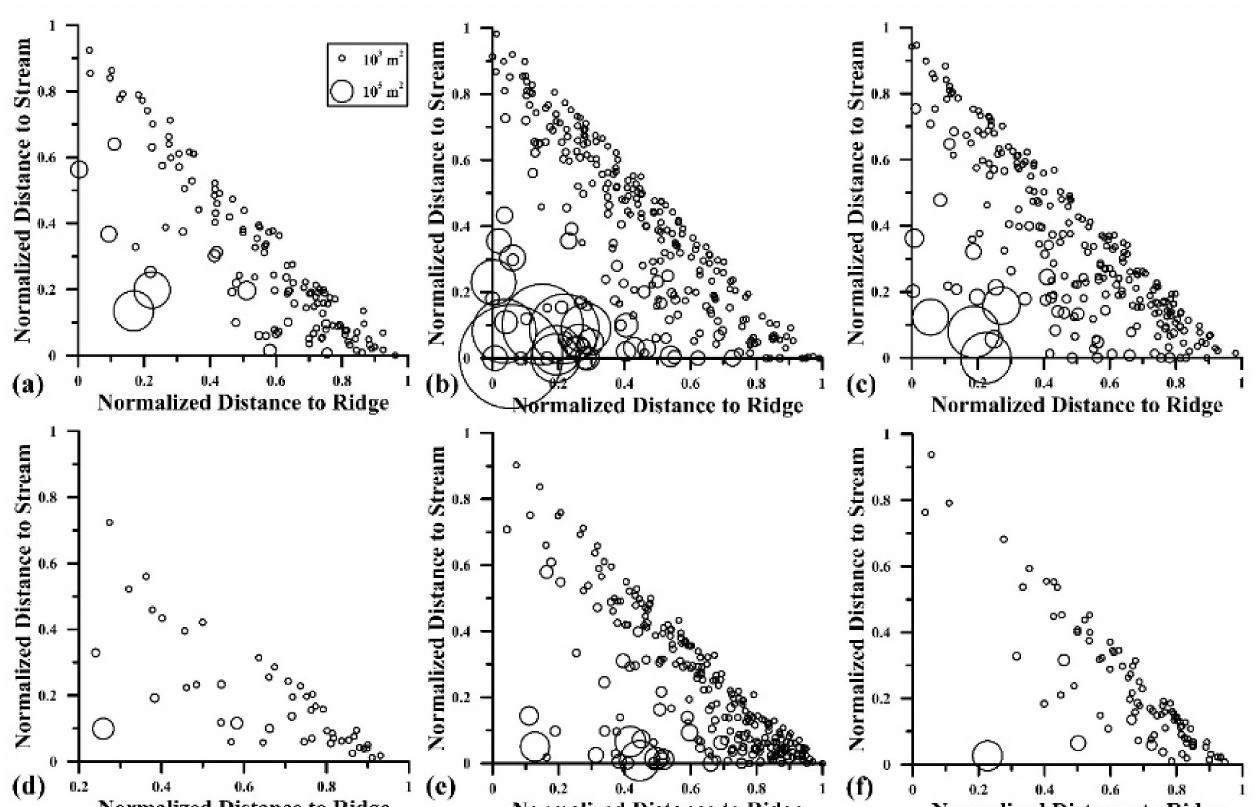
Figure 8. The topographic position analysis of landslide in 2008 ( a – d ), 2009 ( b – e ), and 2015 ( c – f ) in the A03 (up figures) and A31 (down figures) subwatersheds in the ARW